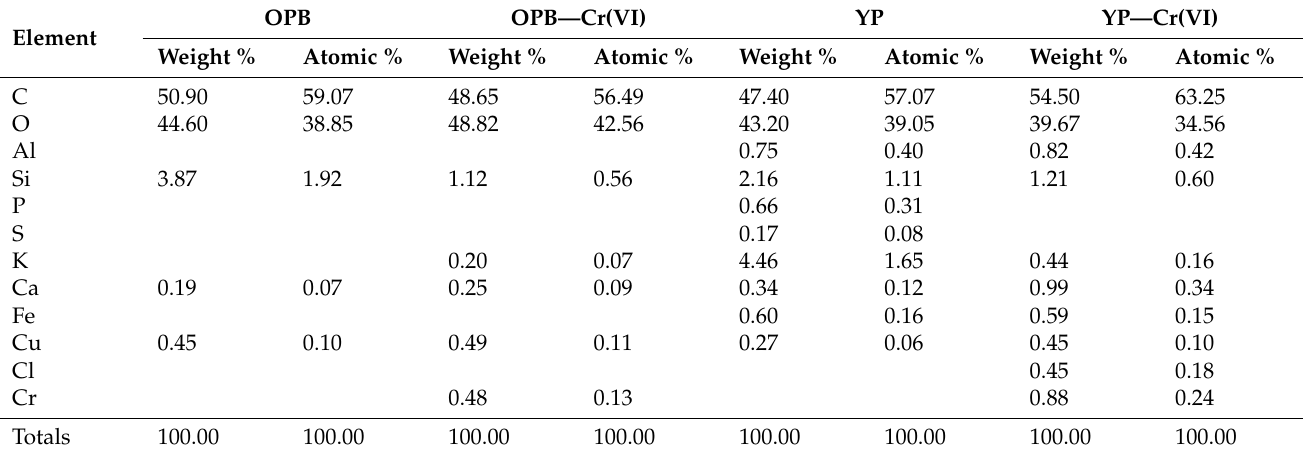
Table 1. EDS compositional